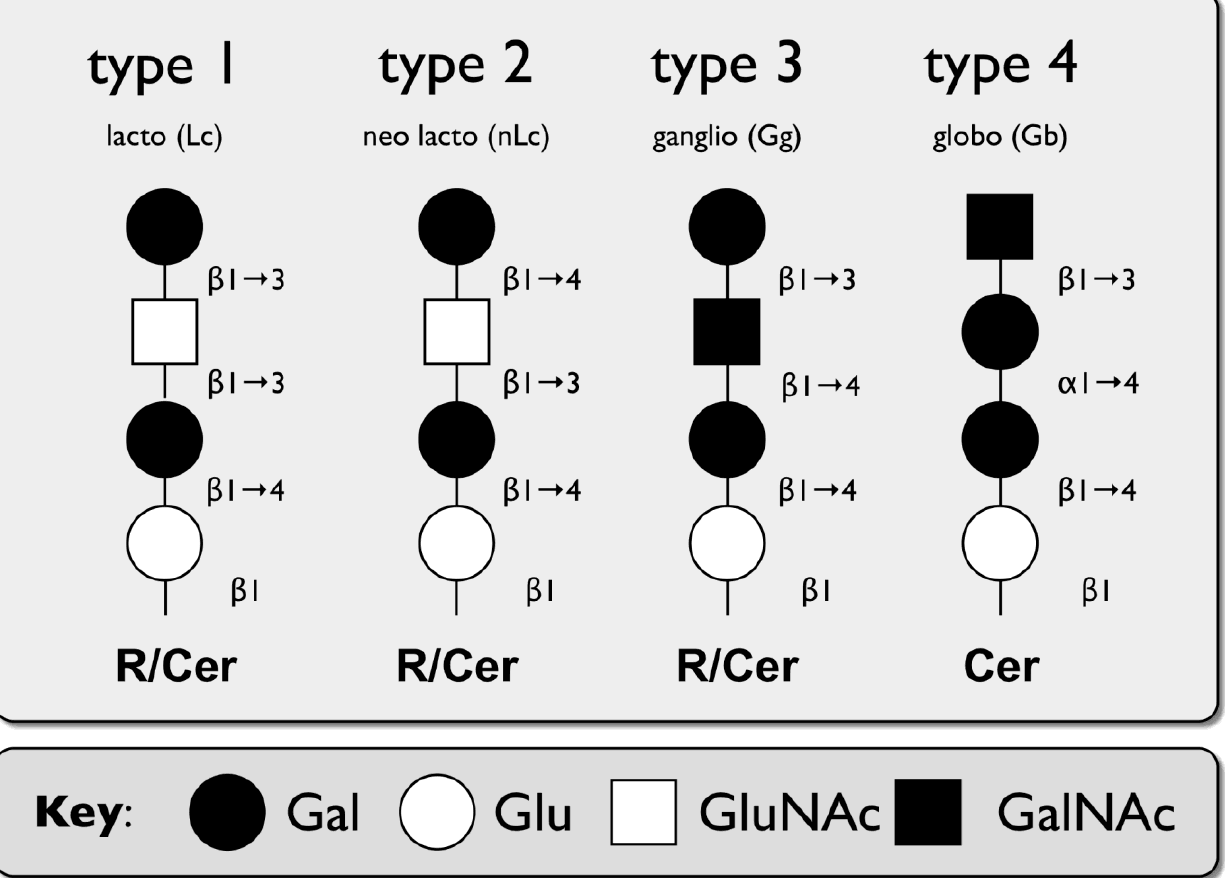
Figure 1. Schematic representation of discussed major core structures of vertebrate glycosphingolipids (GSLs) (based on IUPAC-IUB Joint Commission on Biochemical Nomenclature